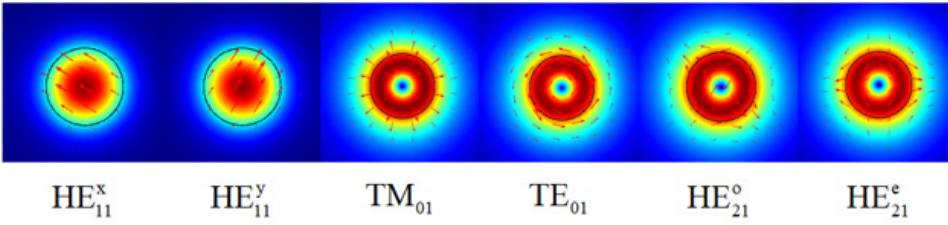
Figure 2. Schematic diagram of TMF transmission mode obtained by simulation.